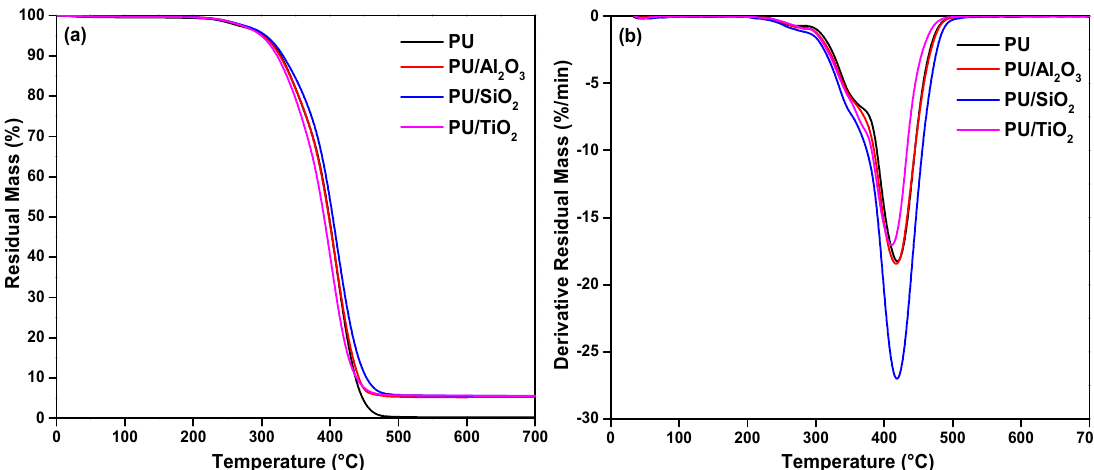
Figure 6. Thermogravimetric (TG) analysis of different PU/ceramic composites; ( a ): residual mass (%) and ( b ) derivative residual mass (%/min).